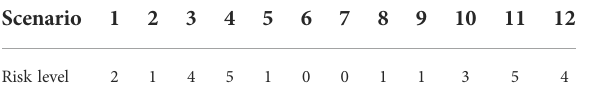
TABLE 10 Security risk level of each cyberattack